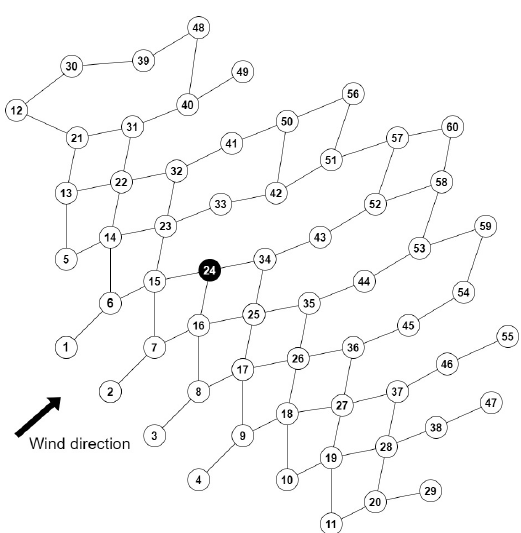
Figure 1. Schematic diagram of the wake effect on the location of 60 units at Princess Amalia wind farm and at a certain wind